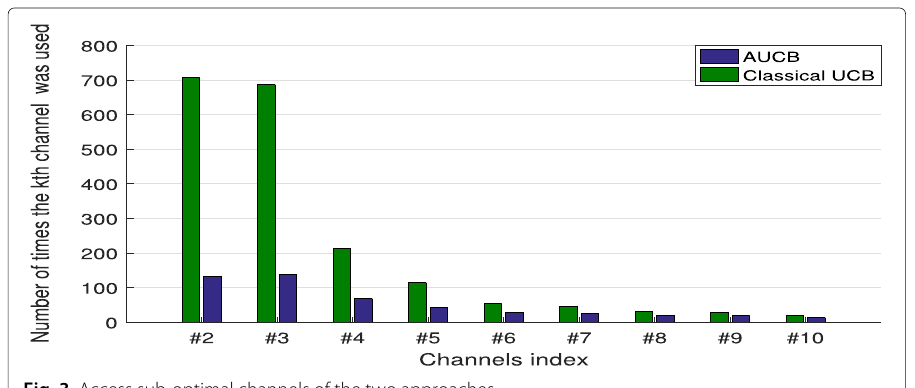
Fig. 3 Access sub-optimal channels of the two approaches